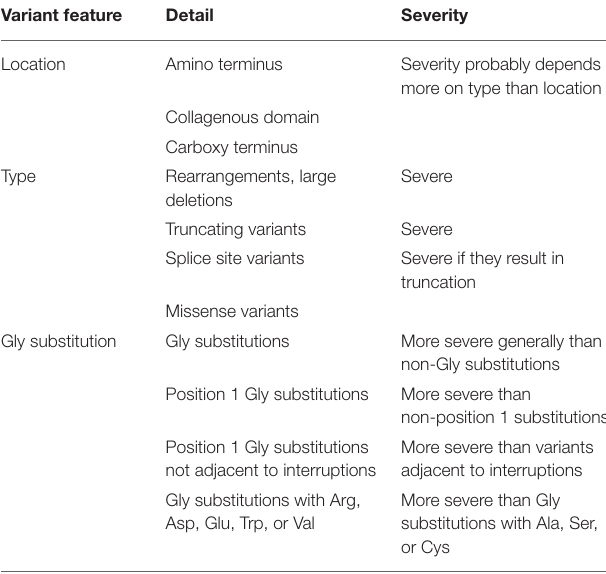
TABLE 3 | Factors determining severity of genetic variants in the COL4A3–COL4A5 genes.